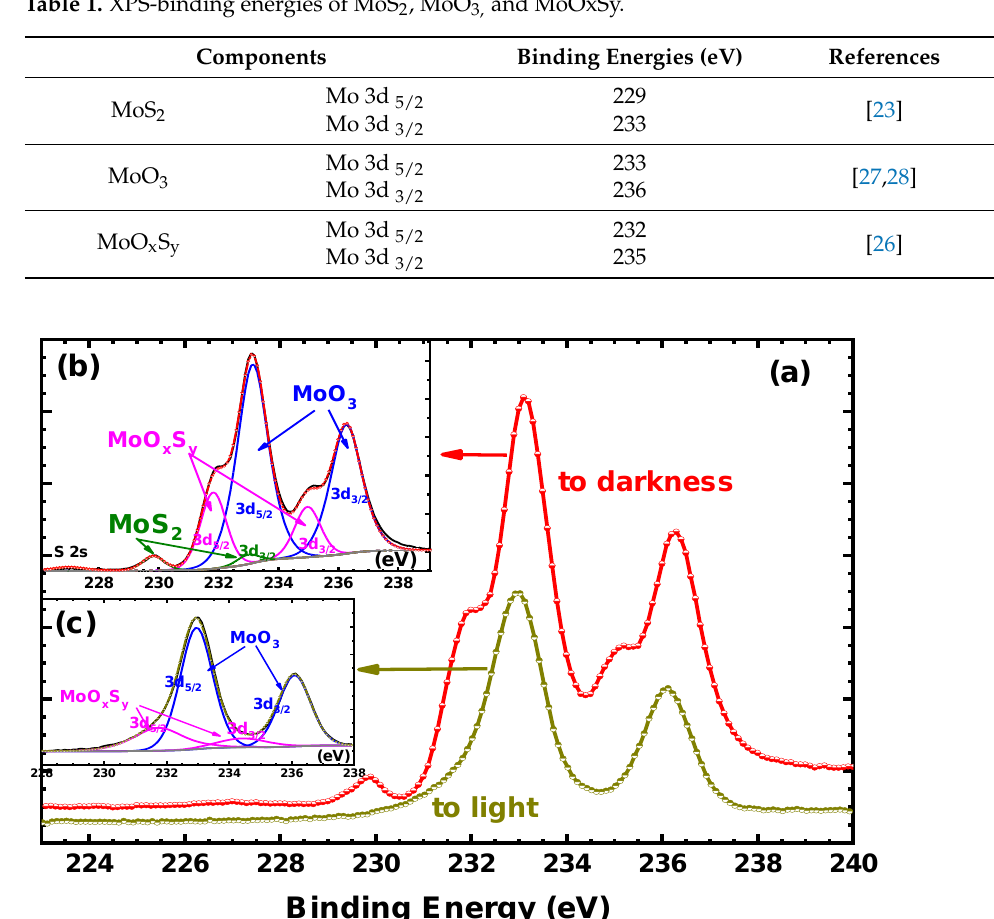
Figure 2. Mo3d spectra of MoS 2 oxidized by H 2 O 2 (10%) for 15 min to light and to darkness ( a ). Inset ( b ) Mo3d decomposition after oxidation to darkness and inset. ( c ) Mo3d decomposition after oxidation to light.